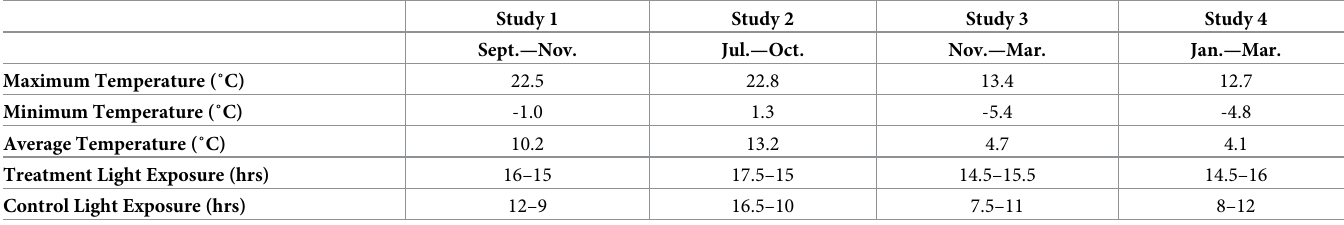
Table 2. Environmental conditions during each